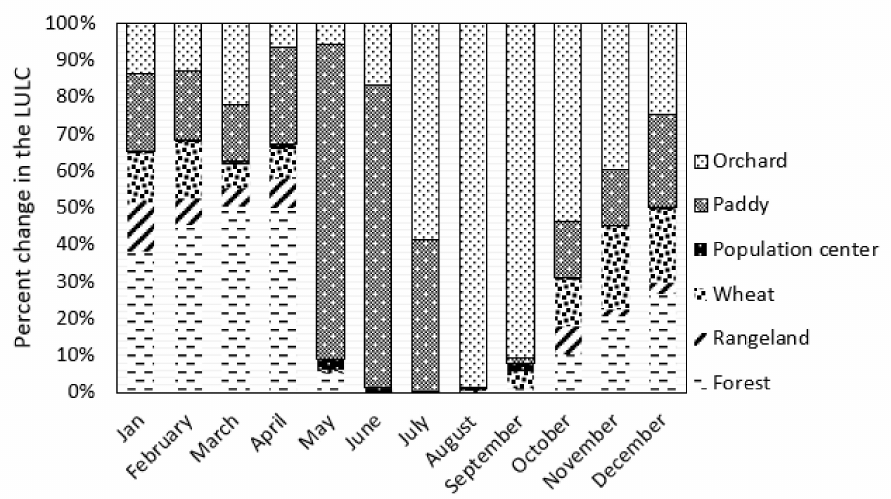
Figure 7. Relative contribution of different land use/land covers (LULCs) to nitrate loading across various